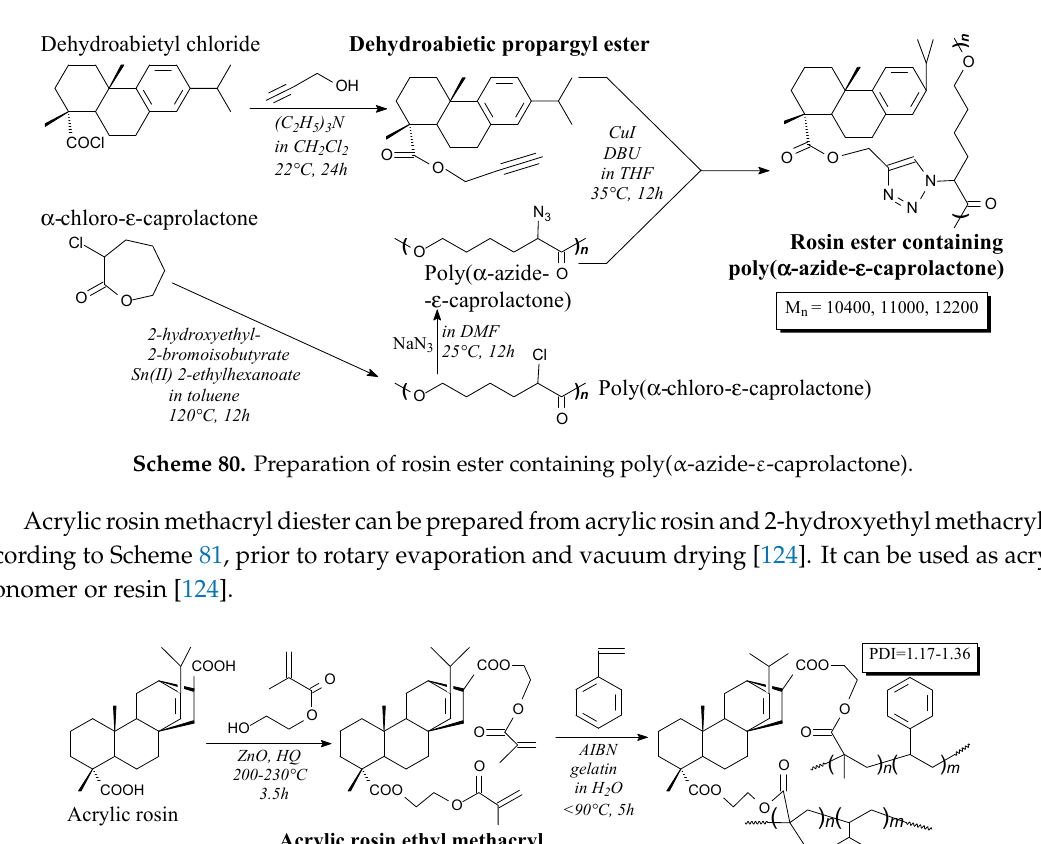
Rosin-tung oil adduct conversion: 72%